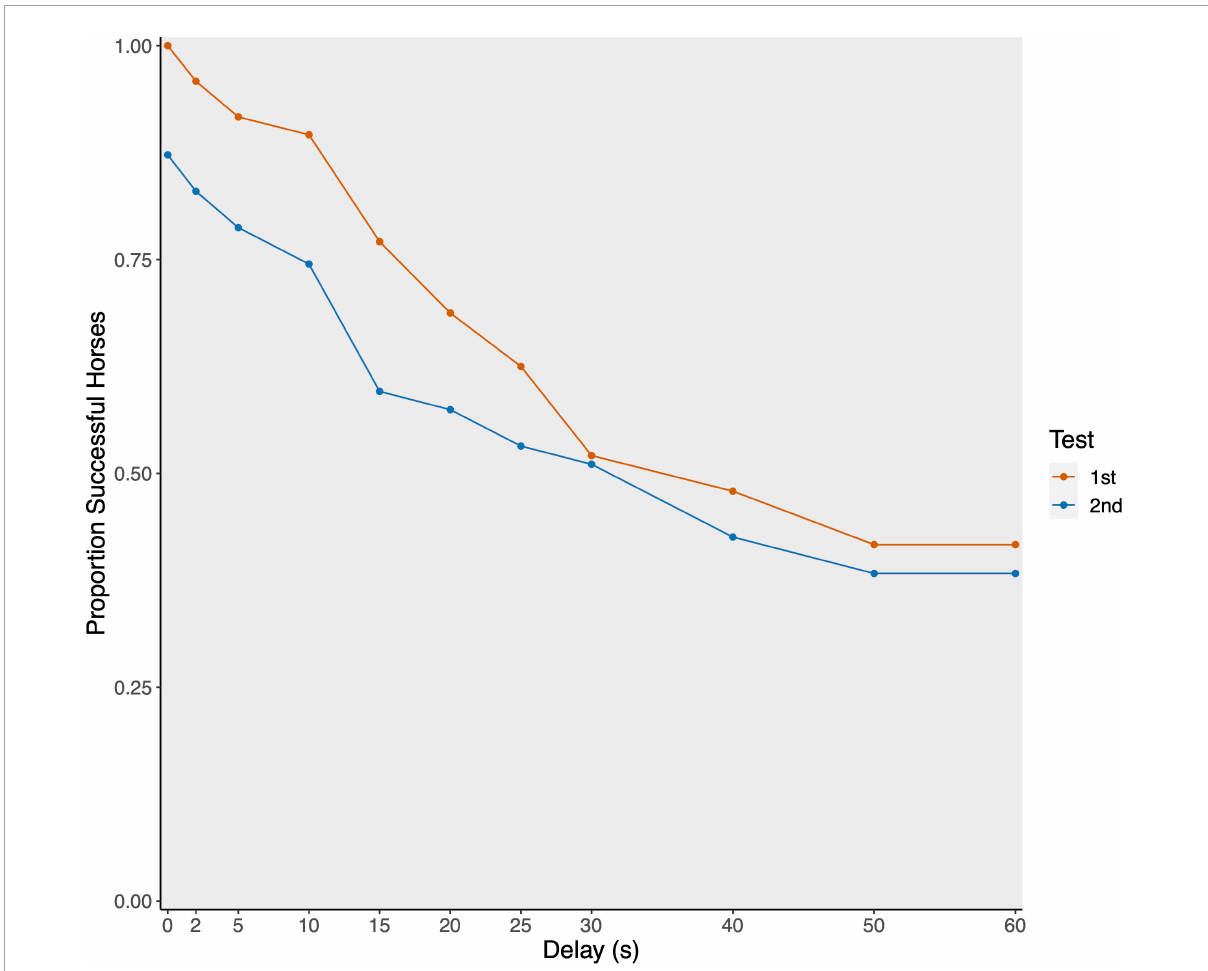
FIGURE1 Proportion of successful horses per delay stage plotted separately for first (red; N = 52) and second (blue; N = 48)